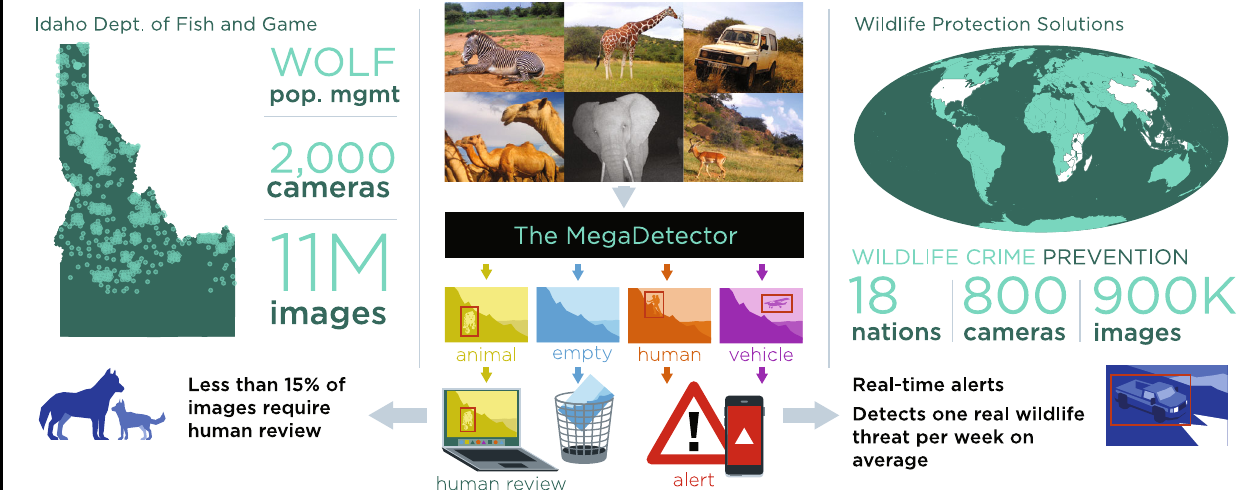
Fig. 6 AI for Wildlife Conservation in Practice: the MegaDetector. The near-universal need of all camera trap projects to ef fi ciently fi lter empty images and localize humans, animals, and vehicles in camera trap data, combined with the robustness to geographic, hardware, and species variability the MegaDetector provides due to its large, diverse training set makes it a useful, practical tool for many conservation applications out of the box. The work done by the Microsoft AI for Earth team to provide assistance running the model via hands-on engineering assistance, open-source tools, and a public API have made the MegaDetector accessible to ecologists and a part of the ecological research work fl ow for over 30 organizations